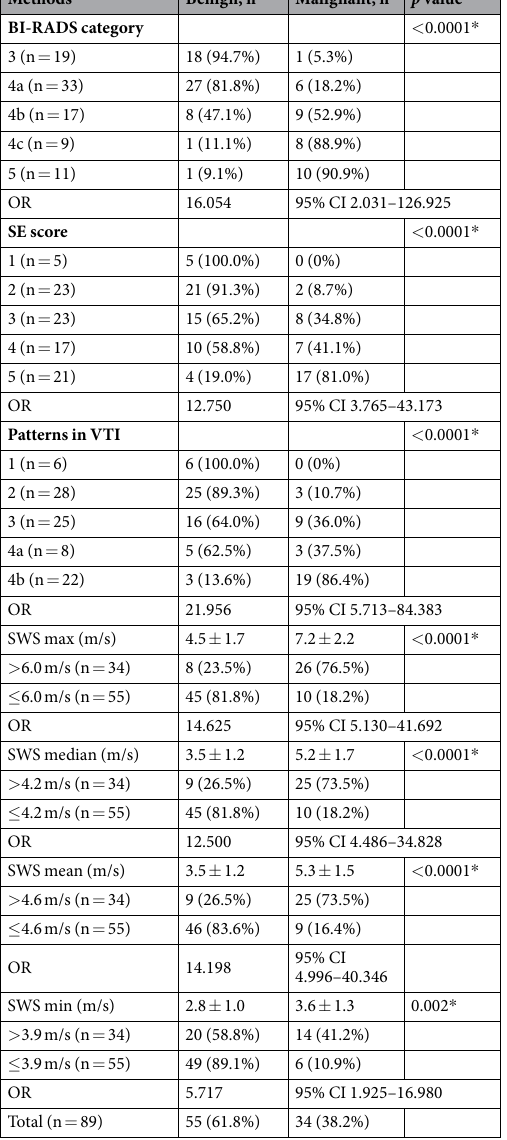
Table 2. Univariate analyses of conventional ultrasound and ultrasound elastography for malignancy prediction. * Indicates statistically significant difference at the level of two-tailed 0.05. Numbers in parentheses are percentage of benign and malignant lesions. n, number; BI - RADS, Breast Imaging Reporting and Data System; SE, strain elastography; VTI virtual touch tissue imaging; SWS, shear wave speed; OR, Odds Ratios; CI, confidence